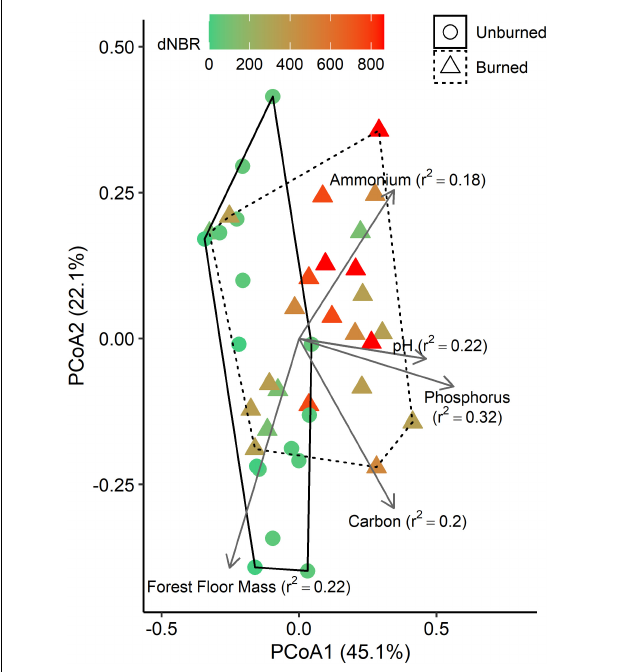
FIGURE 5 | Principle coordinates analysis (PCoA) plots based on a Bray-Curtis distance matrix of imputed MetaCyc pathways grouped into common C-degradation functions. Vectors represent variables that are significantly correlated with one of the PCoA axes, and vector lengths are scaled based on r 2 values. Solid and dashed hulls depict the ordination space that encompasses all burned and unburned samples,